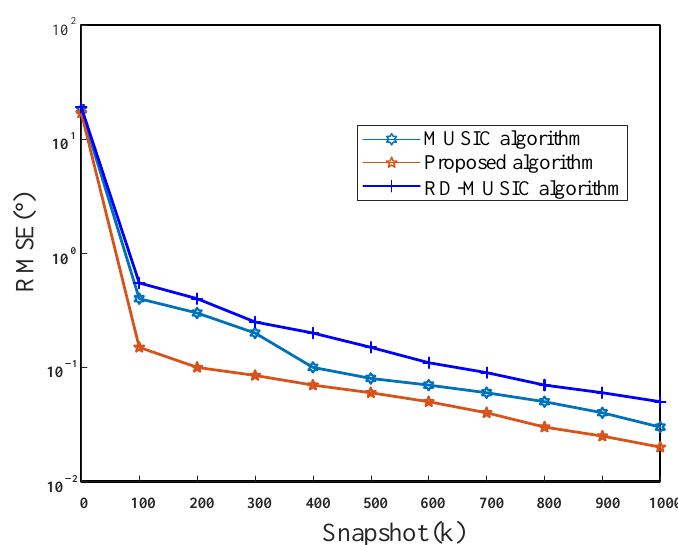
Figure 10. RMSE versus the snapshot for theta.